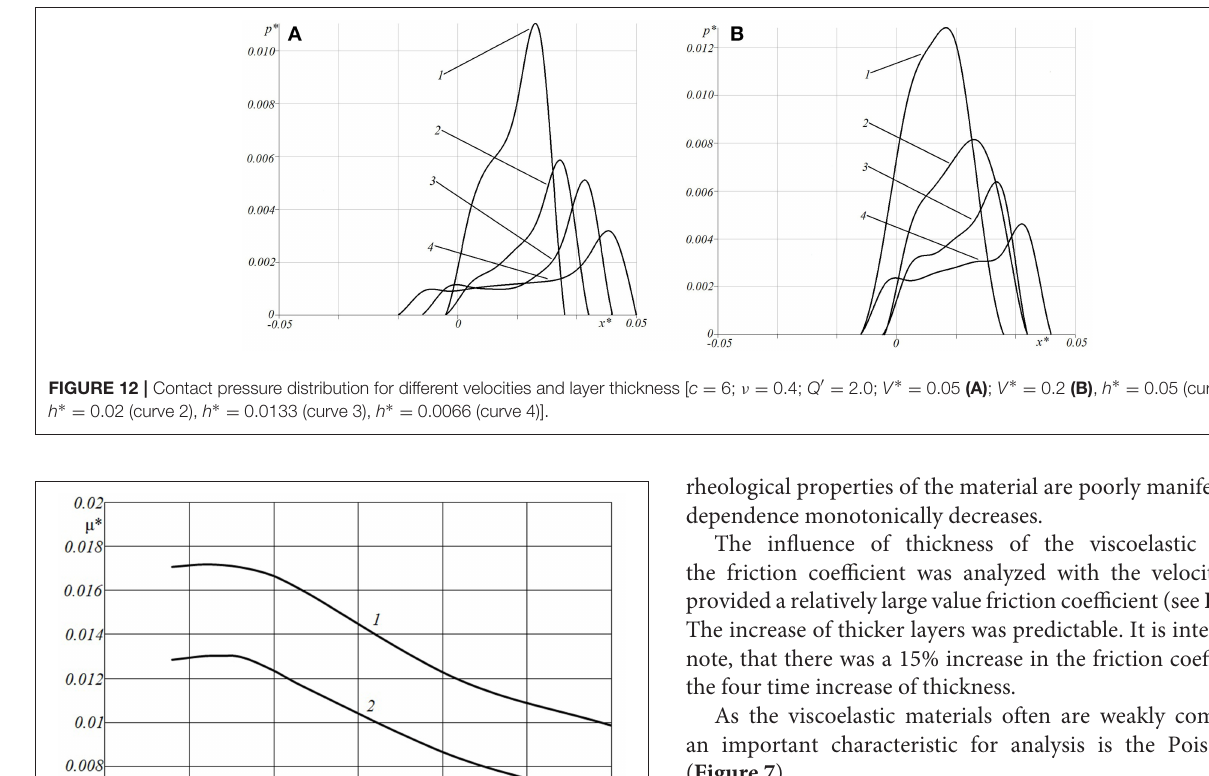
were previously obtained in Koumi et al. (2015), Goryacheva et